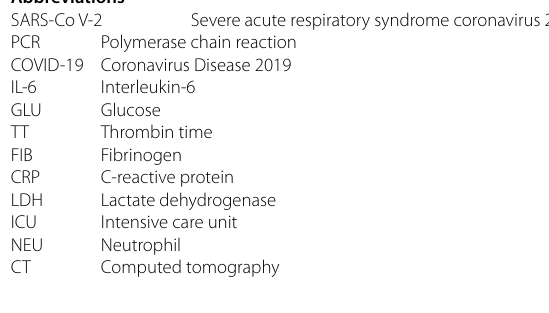
CORAD COVID-19 Reporting and Data System, WBCs White blood cells (4000– 10,000/mm 3 ), ALC Absolute lymphocyte count (1000–4800/mm 3 ), CRP C-reactive protein (0–5 mg/L), LDH Lactate dehydrogenase (135–225 U/L)